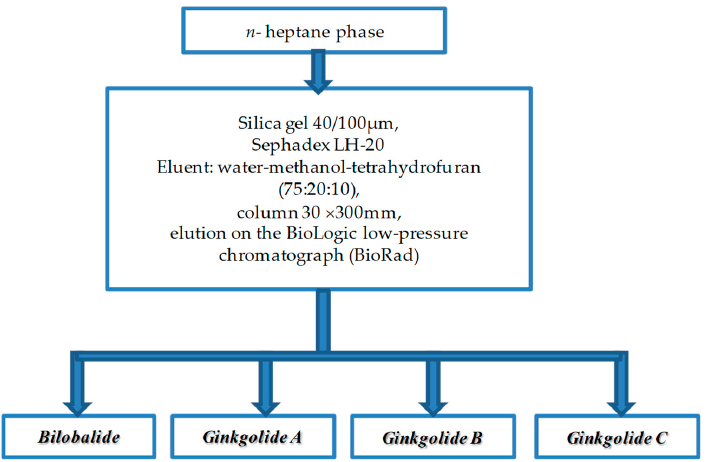
Figure 7. The developed scheme of purification of biologically active substances obtained from the n -heptane phase of Ginkgo biloba extract.